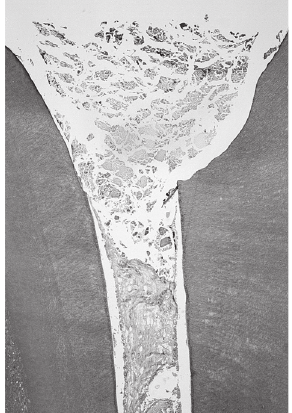
Figure 9. Group IV (zinc oxide eugenol). Absence of dentine bridge. Degener- ated pulp tissue. HE; magnification